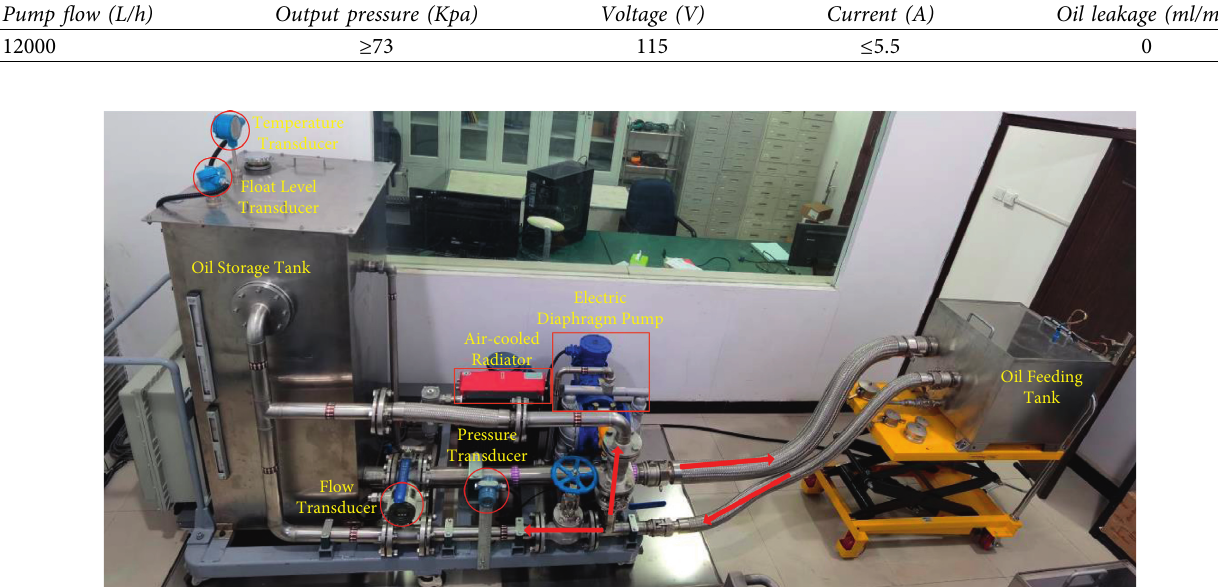
Figure 8: Testbed of the airborne fuel pump.